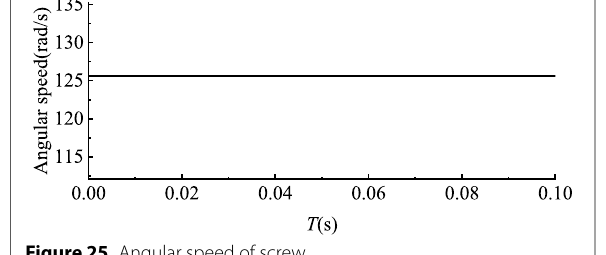
Table 2 Comparison between simulation value and